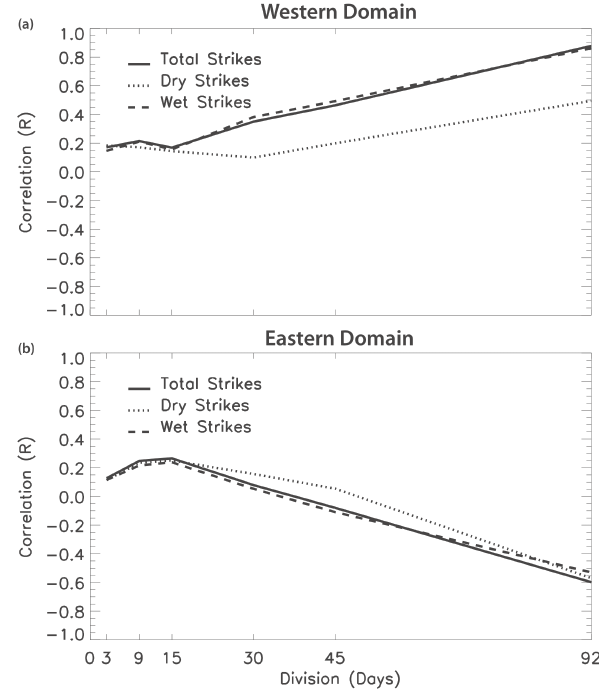
Figure 4. Fig. 4. Correlation coefficients between fire counts and total, wet, and dry lightning strikes computed as a function of the length of temporal segments (ranging from 3 to 92 days) in the western do- main (a) and the eastern domain (b) . The data time series used in the calculation consists of daily-paired fire and lightning data in June– August (92 days) of 2000–2006. Please see Sect. 5.2 for